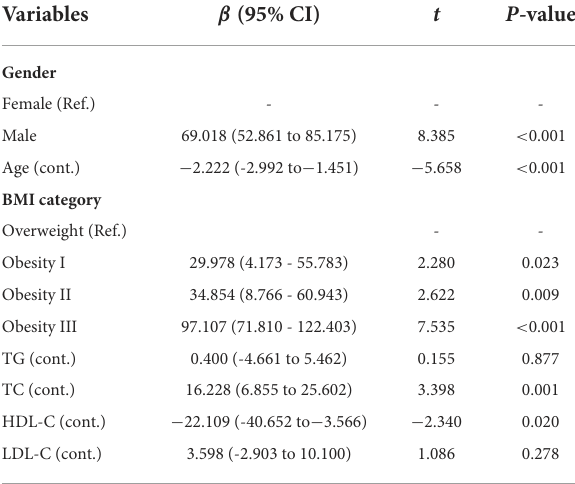
TABLE 6 Multiple linear regression between SUA and risk factors of obesity in the model.